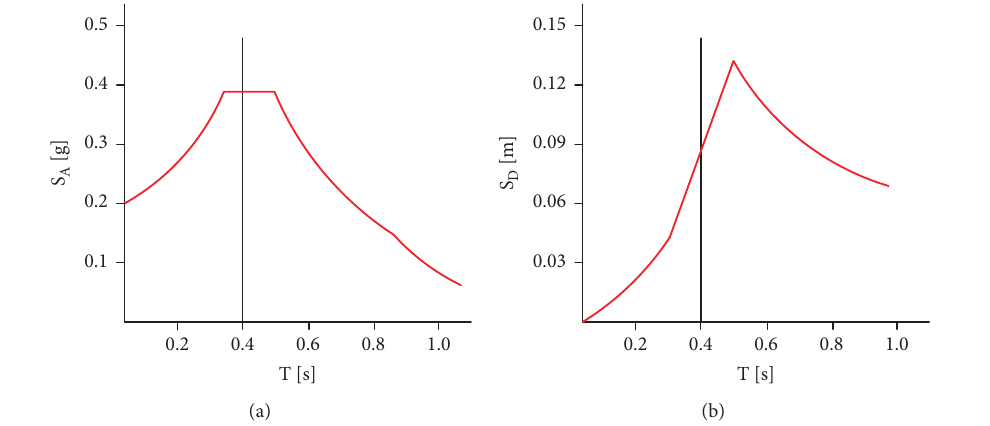
Figure 3: Acceleration (a) and displacement (b) response spectra.